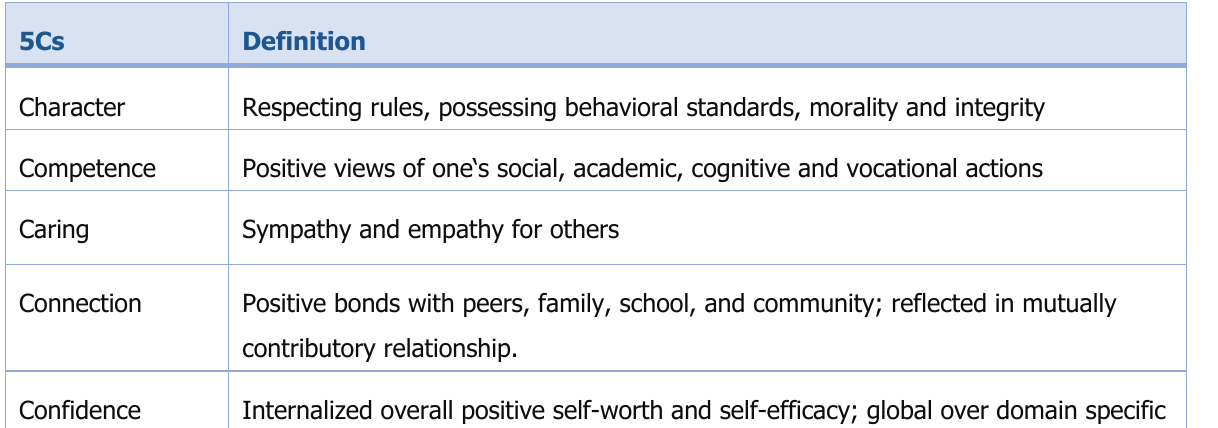
Table 2. Definitions of the 5 Cs of Positive Youth